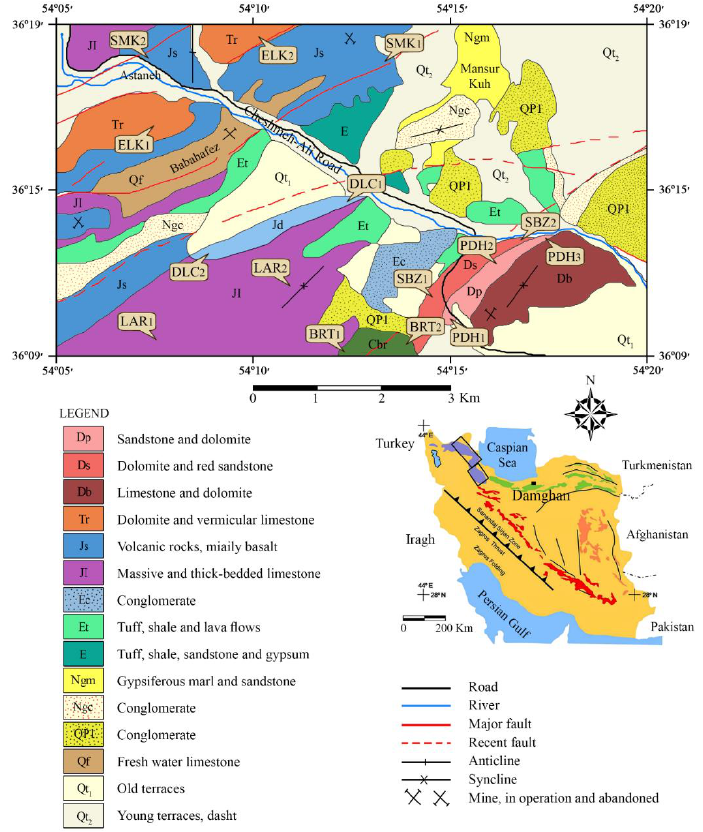
Figure 1. Sampling locations and geological map of the study area [70].